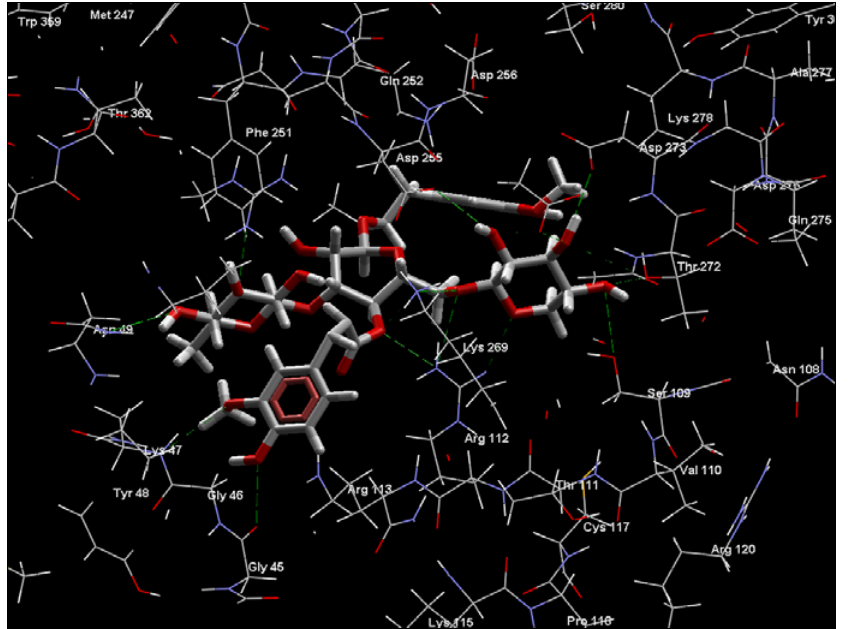
Figure 1. Some predicted interactions (green dashed lines) between angoroside C (white and red) and active site residues Arg 112, Ser 109, Lys 269, Gly 45, and Asp 255 of T brucei